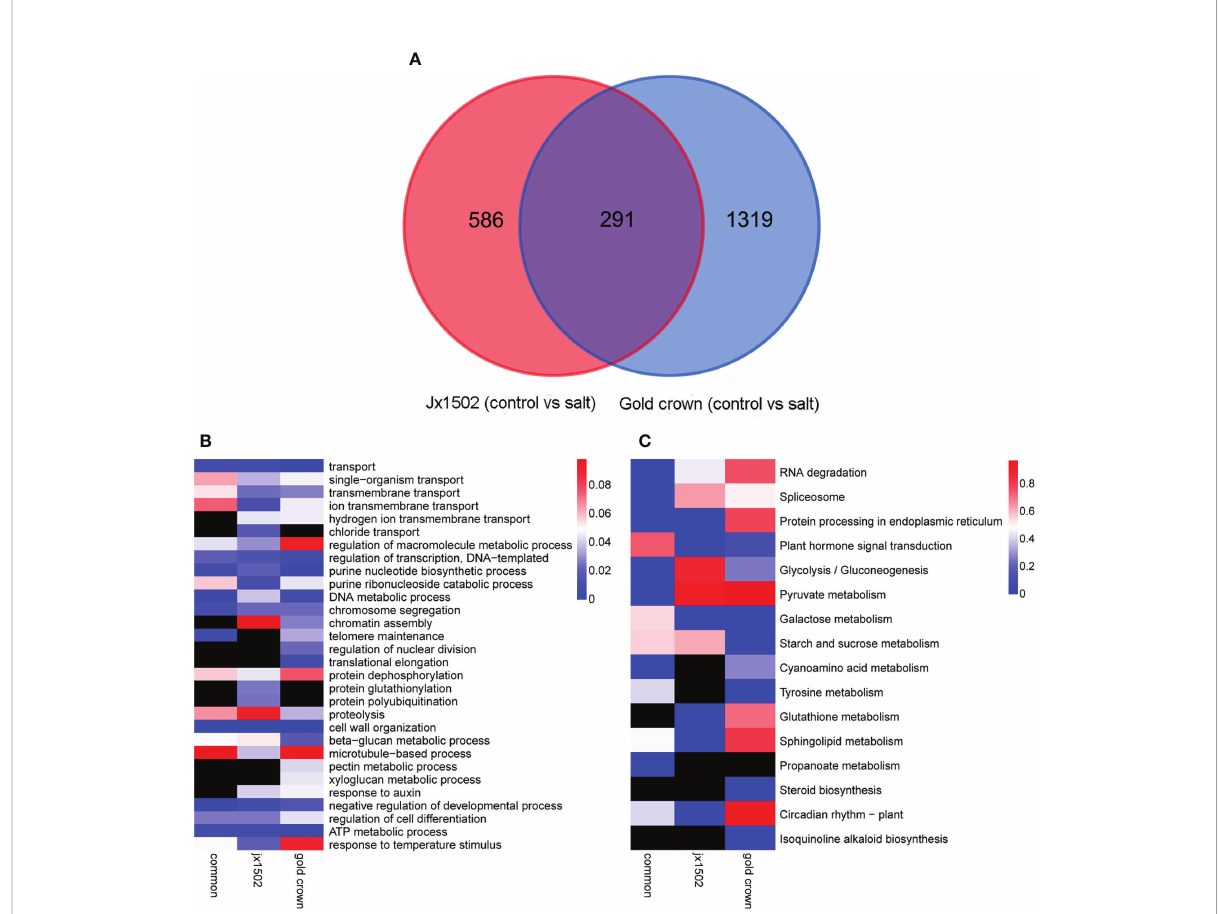
FIGURE 1 (A) Venn diagram showing speci fi c and common differentially expressed genes in ‘ jx1502 ’ and ‘ gold crown ’ under salt stress. (B, C) Signi fi cantly enriched GO terms and KEGG pathways with ‘ jx1502 ’ -speci fi c, ‘ gold crown ’ -speci fi c, and common DEGs under salt stress. The color scale represents the p-value of the enriched term and pathway. The black boxes indicate that there are no DEGs that were enriched in the corresponding term or